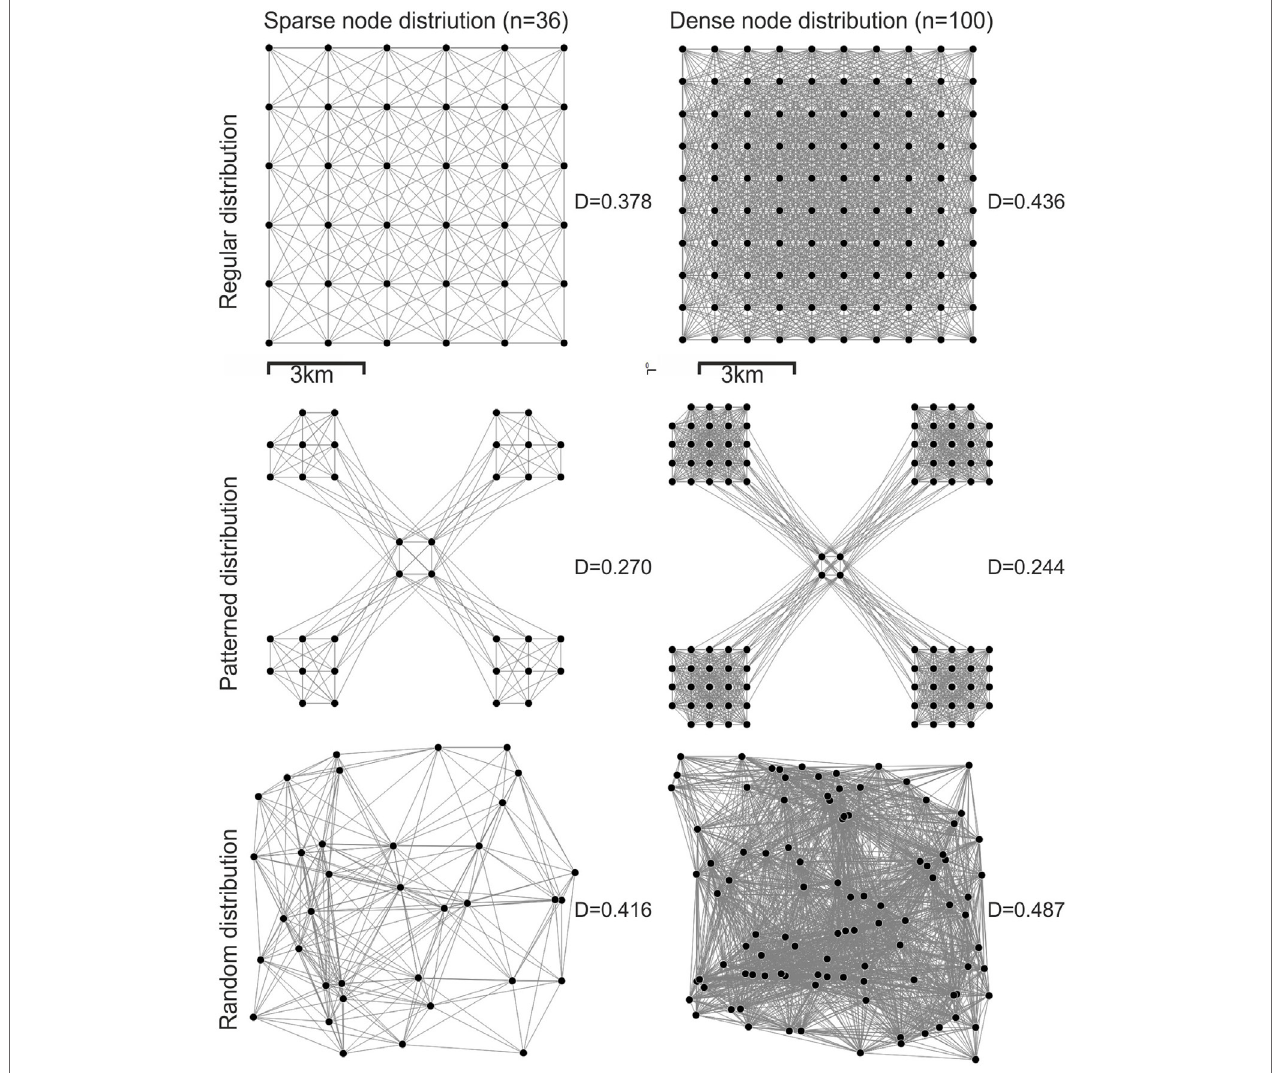
FigUre 6 | Densities (D) of visibility networks between differently distributed observation locations in a completely flat square landscape of 9 km by 9 km. The following experiment settings were used for Figures 6 – 8 : maximum viewing distance = 5 km; curvature of the earth taken into account; elevation observation points = 1.6 m; elevation observed point = 0